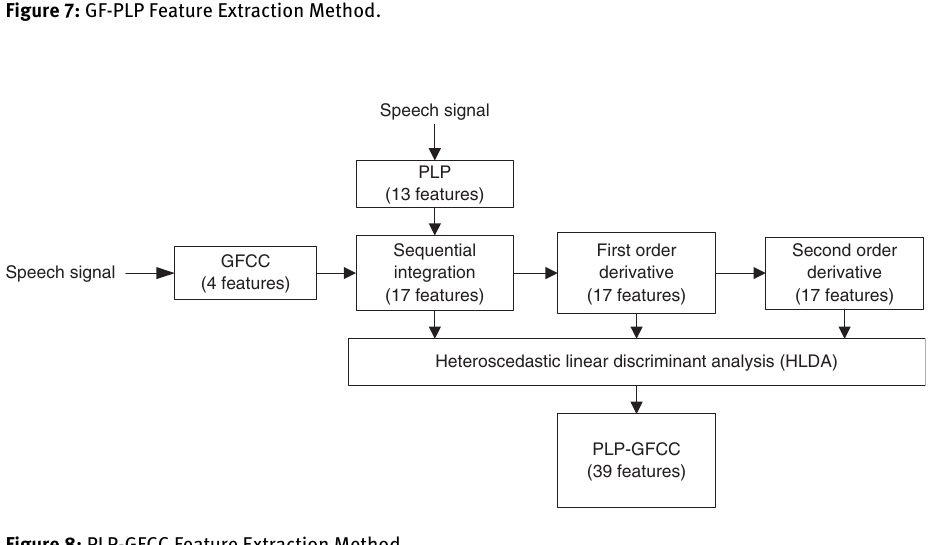
Figure 8: PLP-GFCC Feature Extraction